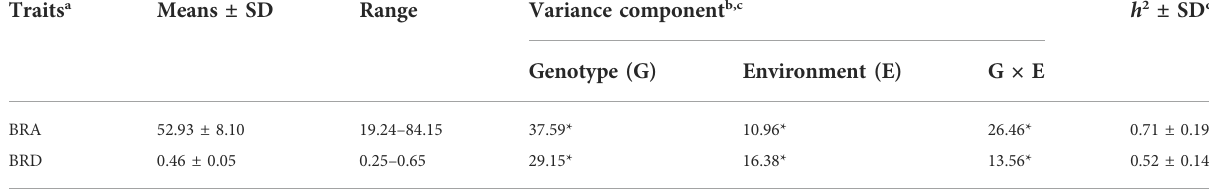
TABLE 1 Phenotypic variation distribution, analysis of variance, and broad-sense heritability of BRA and BRD.